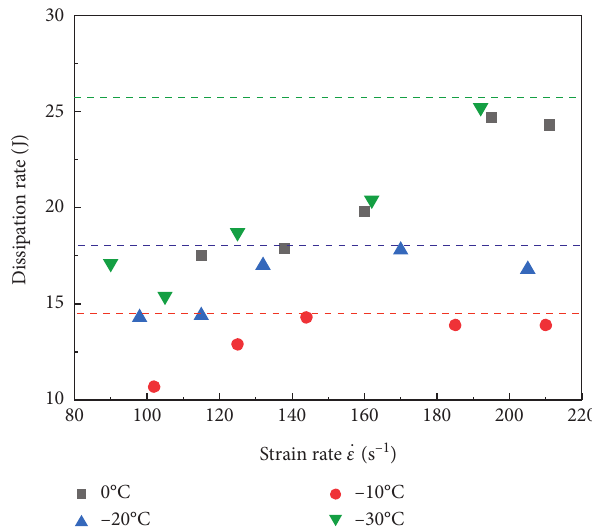
Figure 9: Relationship between energy dissipation rate and strain